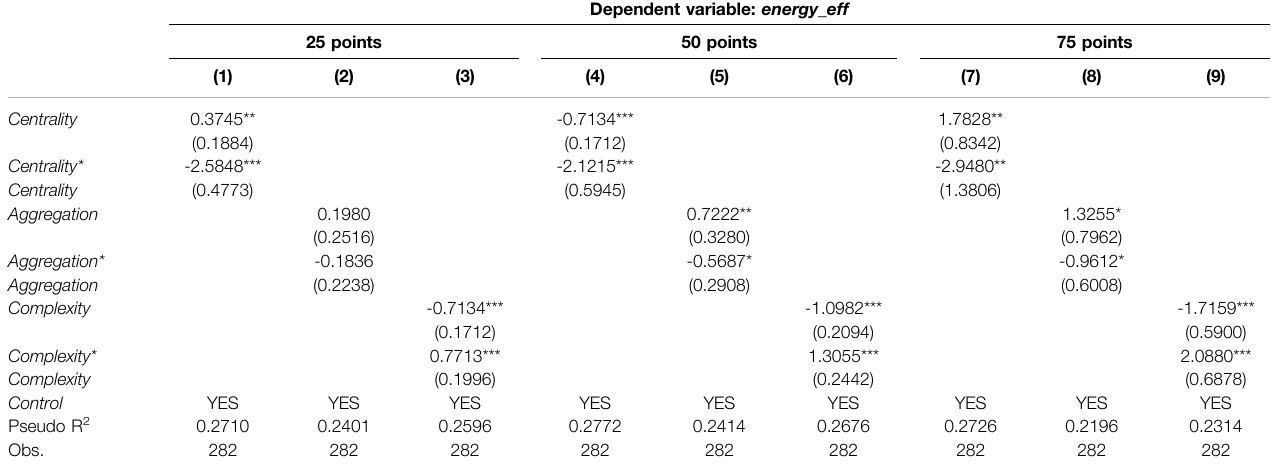
TABLE 3 | Quantile regression estimation results.